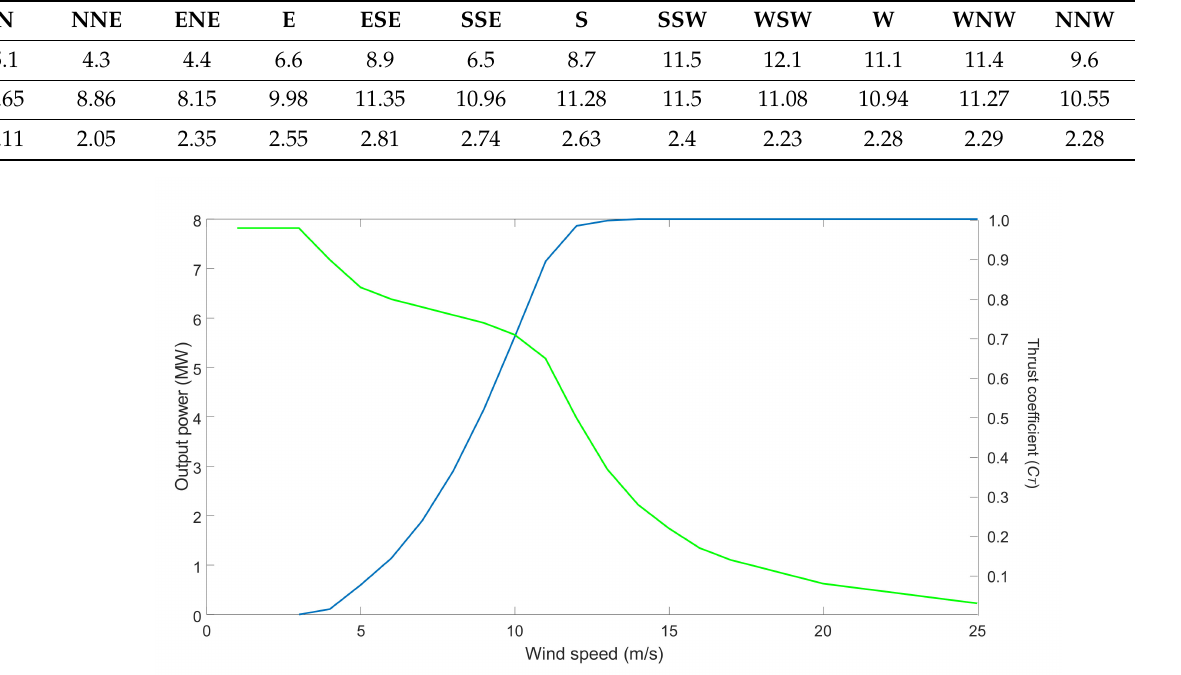
Table 1. Wind data for the test cases under consideration.